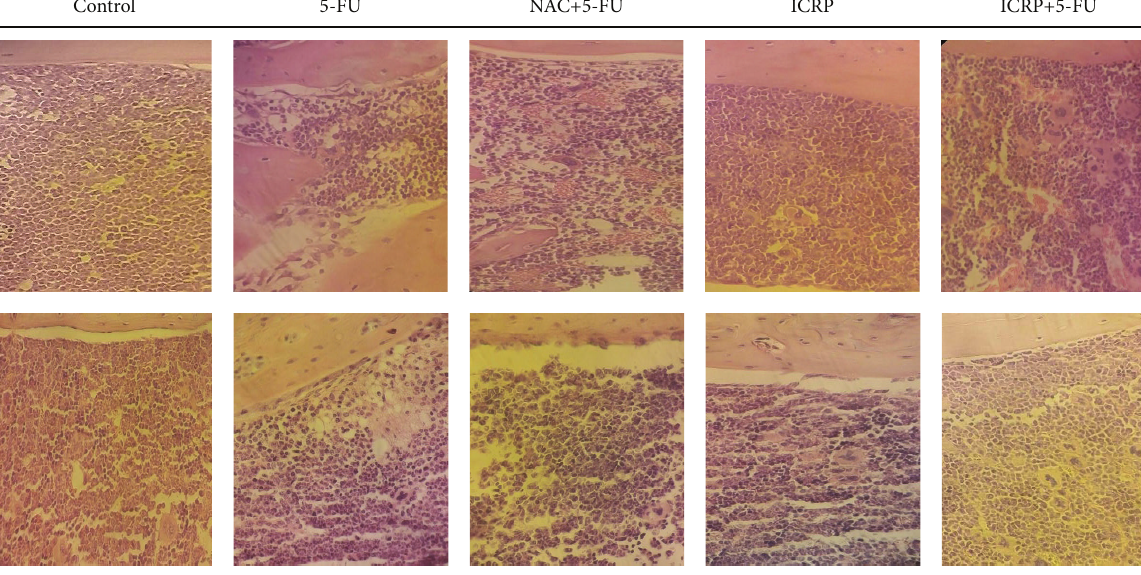
the control. The ICRP + 5-FU group increased body weight similar to the control group (Table